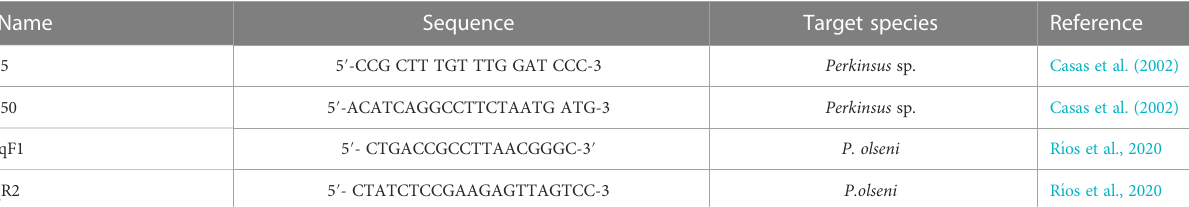
TABLE 1 List of the primers used to detect Perkinsus spp. with PCR and qPCR in this